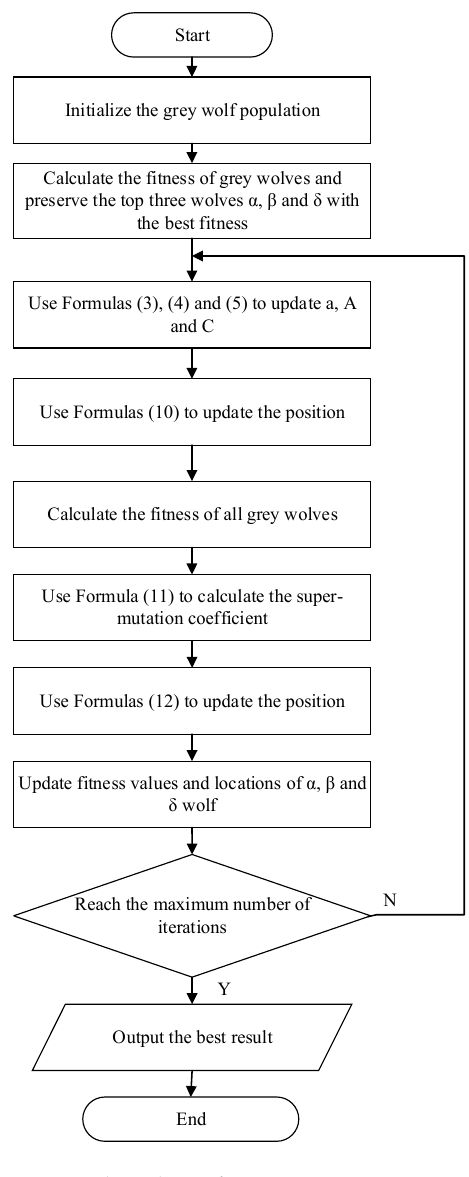
Figure 4. Flow chart of pGWO-CSA.